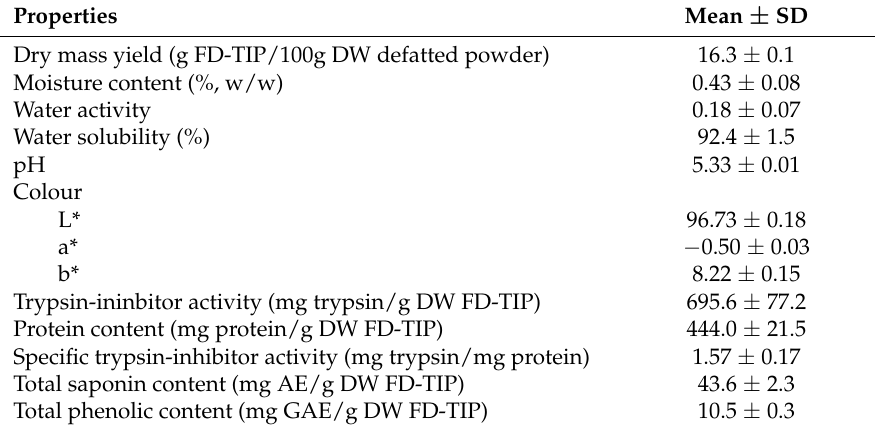
Table 7. Physicochemical properties the trypsin-inhibitor freeze-dried